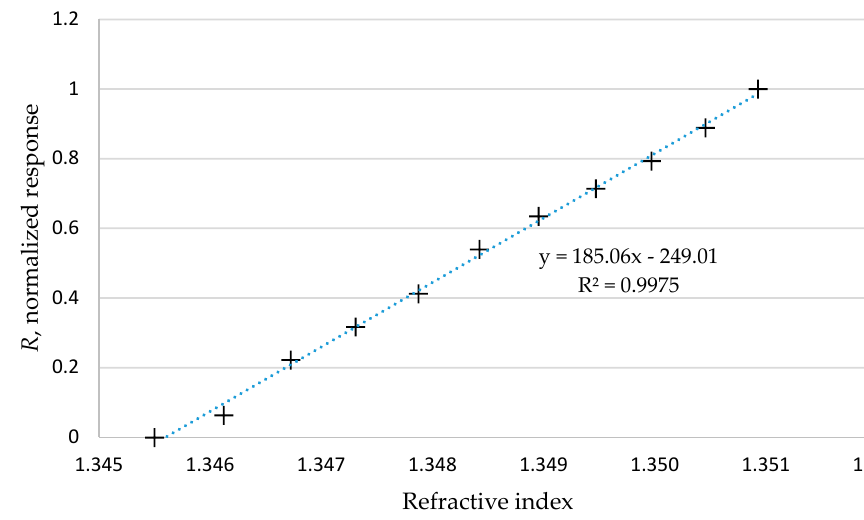
Figure 6. Normalized response of P-233 against refractive index change.